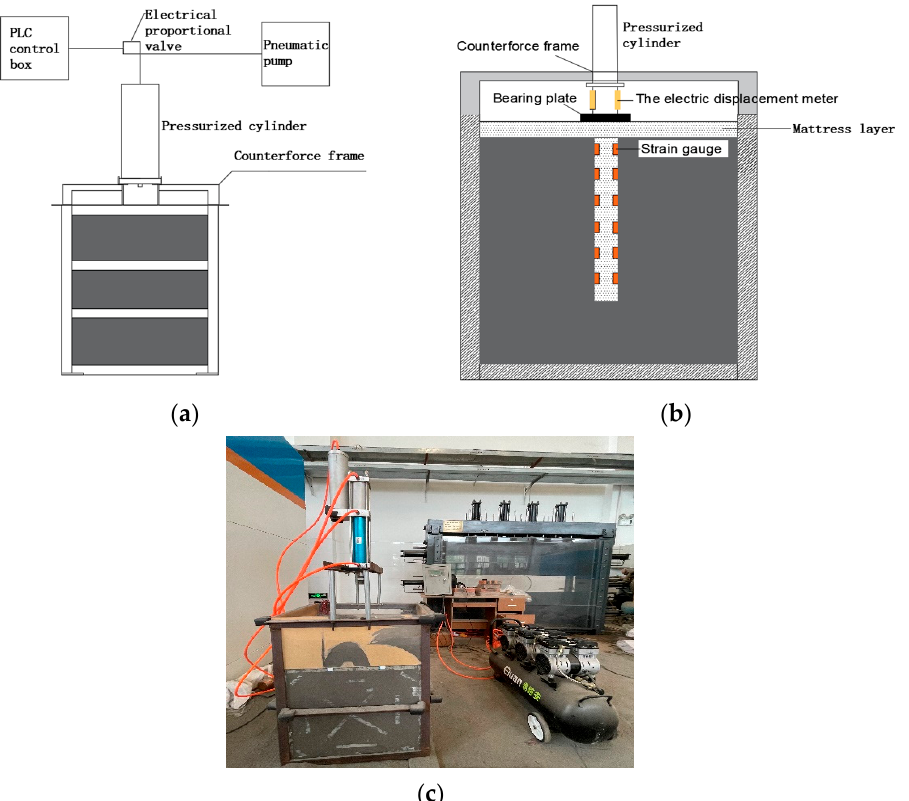
Figure 1. Diagram of the CFMP fly ash composite foundation model test. ( a ) Schematic diagram of model test layout; ( b ) Model test instrument layout; ( c ) Model test site diagram. model test layout; ( b ) Model test instrument layout; ( c ) Model test site